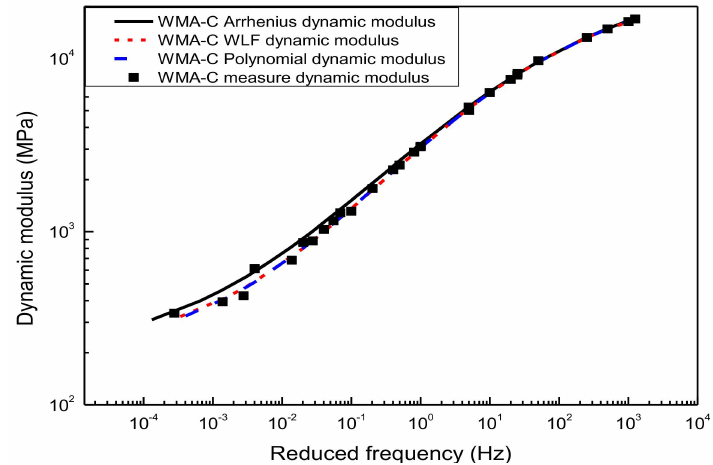
Figure 9. Generalized sigmoidal dynamic modulus master curve of